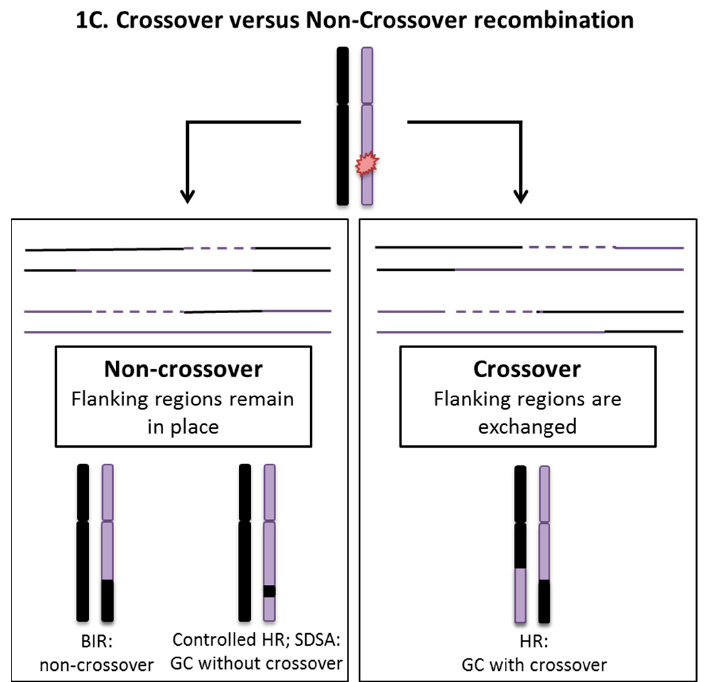
Figure 1. ( A ). Replication restart by homologous recombination and actions that control it at pre-synapsis or synapsis. ( a ) Several possible branched DNA structures can arise when replication forks are compromised as a result of chemical damage or protein bound DNA complexes. These include ssDNA gaps and DNA strand breaks, indicated by the red paint-splash. Exposed single stranded